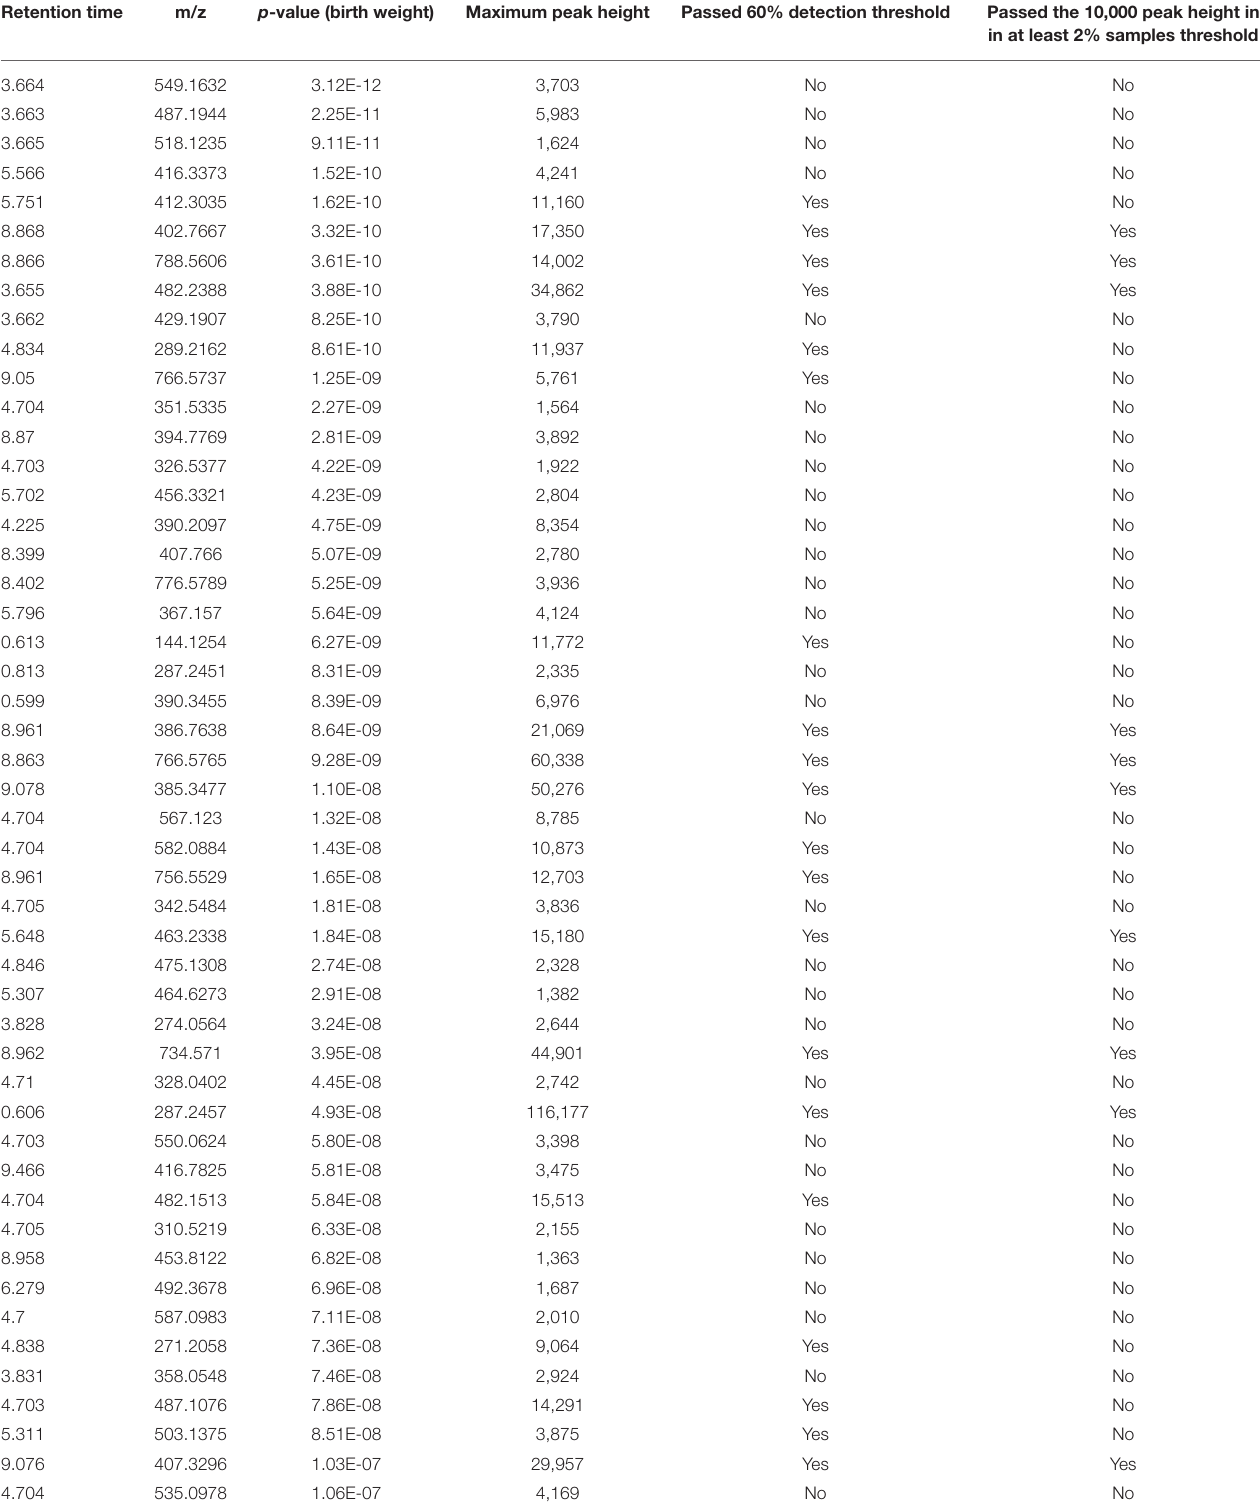
TABLE 5 | Top 50 peaks that were significantly associated with birth weight using a spearman correlation coefficient corrected for multiple hypothesis testing using the FDR approach. Retention